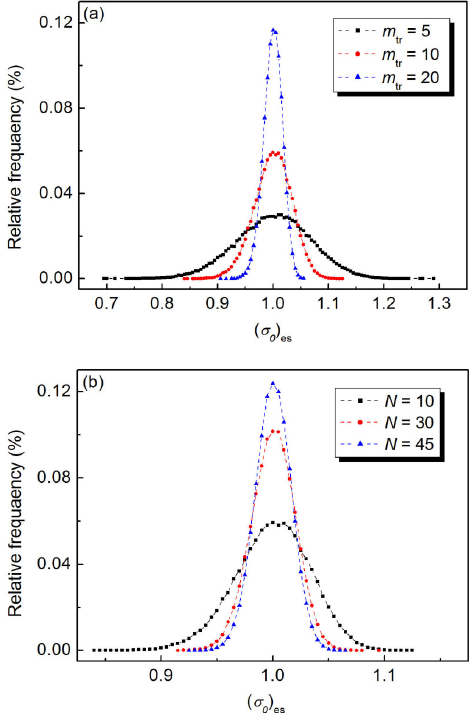
Fig. 10 Empirical probability density functions of estimated with the LS method: (a) N = 30; (b)